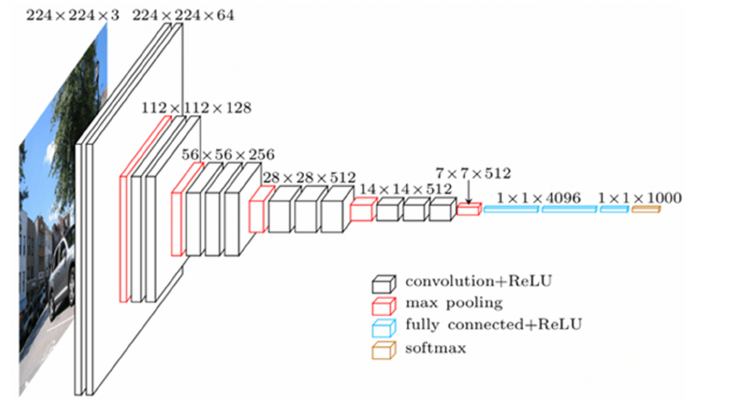
Figure 9. Transfer Learning Architecture from [32].